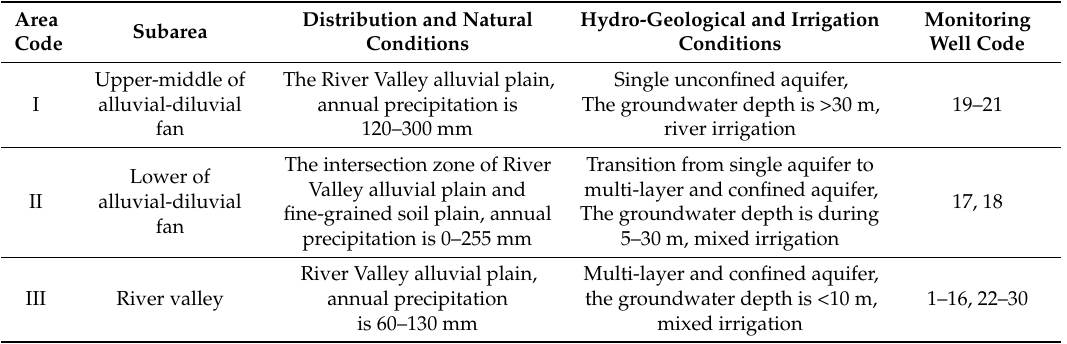
Table 2. The physical and hydro-geological conditions of the study area, together with the monitoring wells in different sub-areas